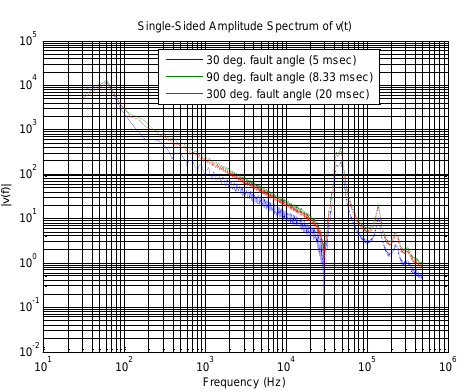
Fig. 12. FFT analysis for phase-c secondary voltage for different fault inception